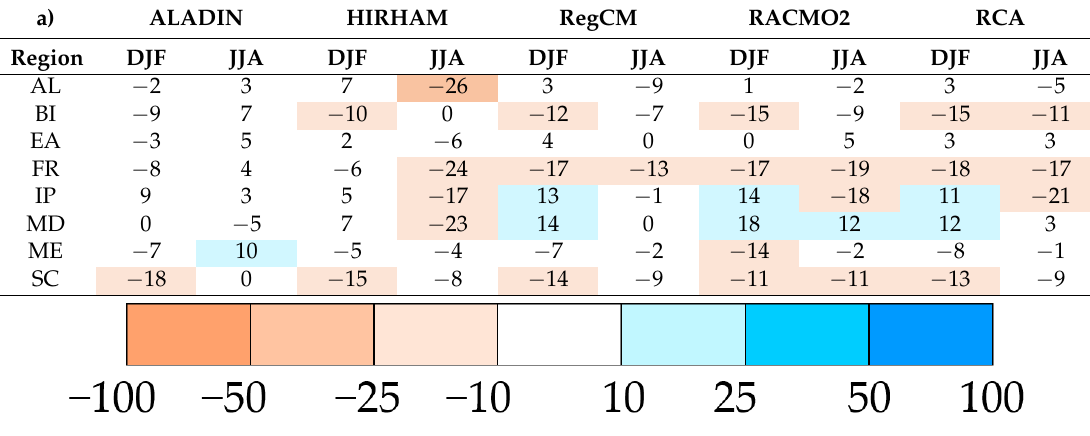
Table 7. Residual bias of the seasonal amount of simulated precipitation (a) and of the seasonal mean of the simulated temperature (b) in the case of eQM bias correction in the test period in eight different regions: the Alps (AL), the British Isles (BI), Eastern Europe (EA), France (FR), the Iberia Peninsula (IP), the Mediterranean (MD), Mid-Europe (ME) and Scandinavia (SC) in DJF and JJA. The bias values are in % and in °C for precipitation and temperature, respectively.